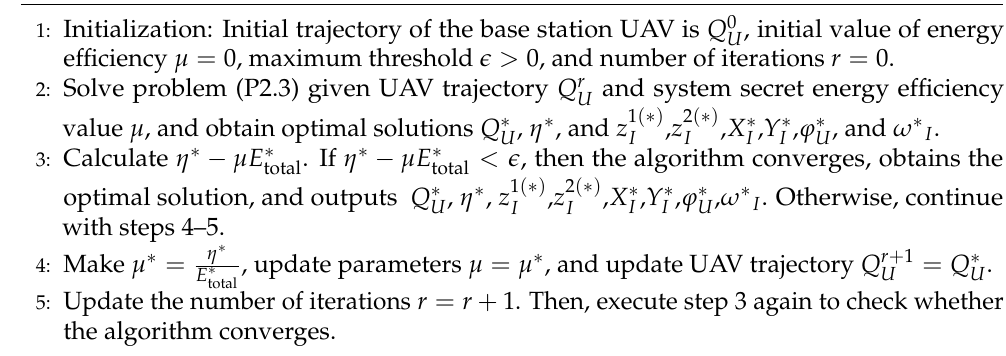
Algorithm 1 Trajectory Planning Algorithm for Problem (P3).